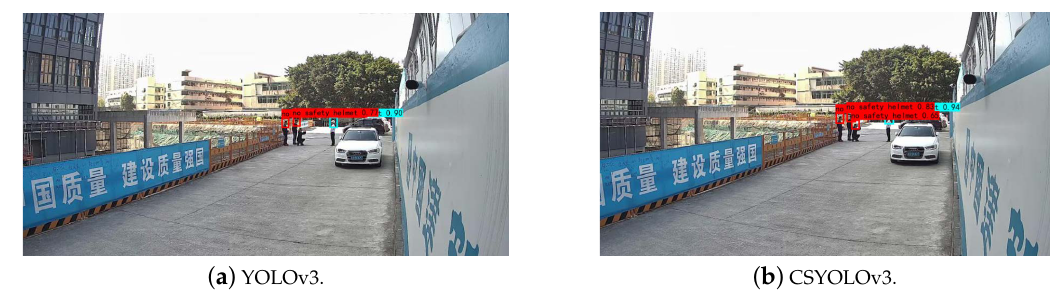
Figure 9. Results of dense SHW detection.